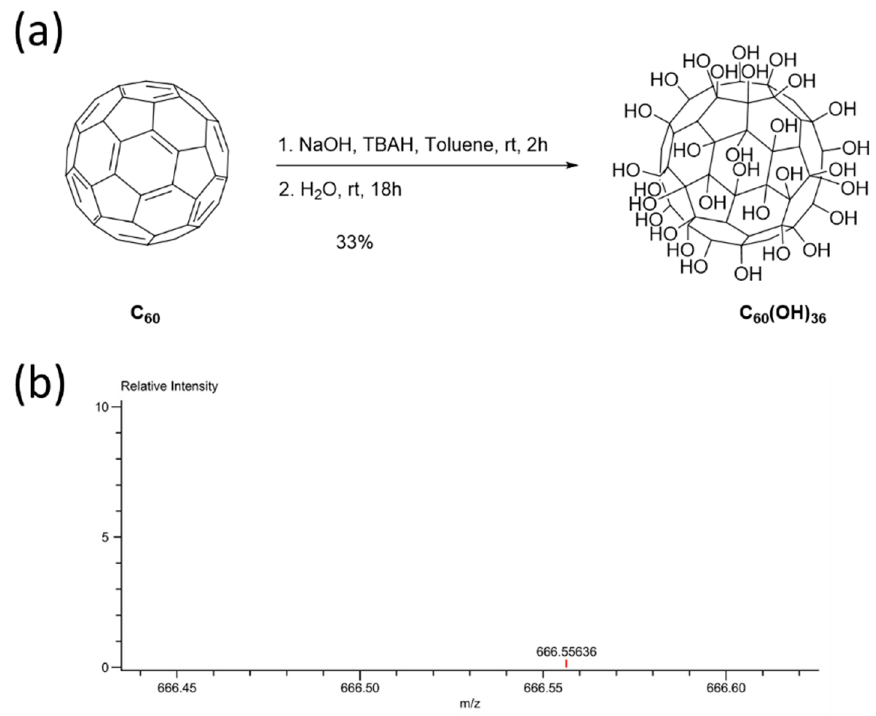
Figure 1. ( a ) Synthesis procedure for fullerenol C 60 (OH) 36 ; ( b ) ESI-TOF MS spectral data.